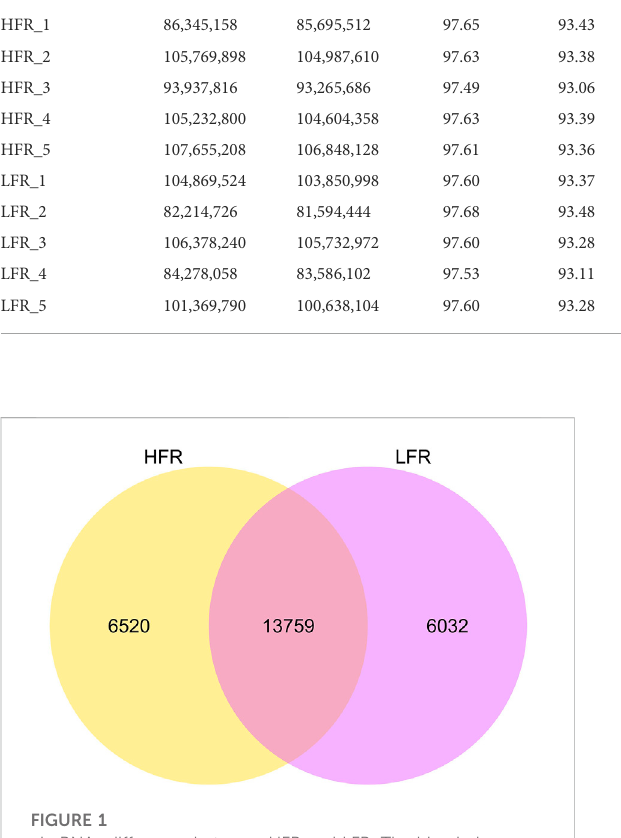
FIGURE 1 circRNAs difference between HFR and LFR. The big circle represents each comparison combination, the sum of the numbers in each big circle represents the total number of circrnas identi fi ed by the comparison combination, and the overlapping part of the circle represents the number of circrnas common between the